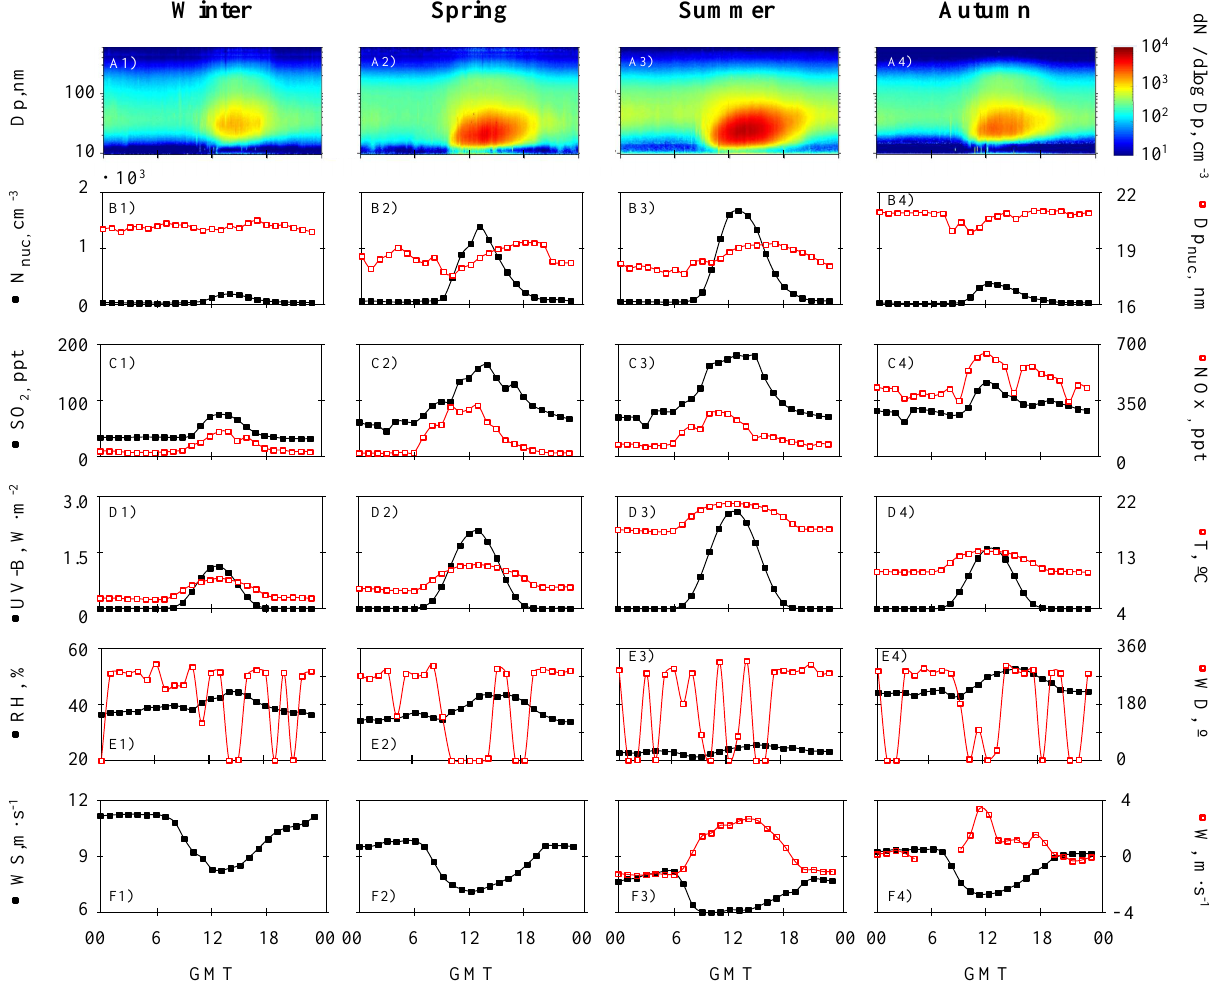
Fig. 5. Daily evolution (hourly mean values) per season of (A) aerosol particle number size distribution, (B) nucleation mode particle concentrations ( N nuc ) and the geometric mean diameter (Dp nuc ), (C) SO 2 and NO x , (D) UV-B and temperature ( T ), (E) relative